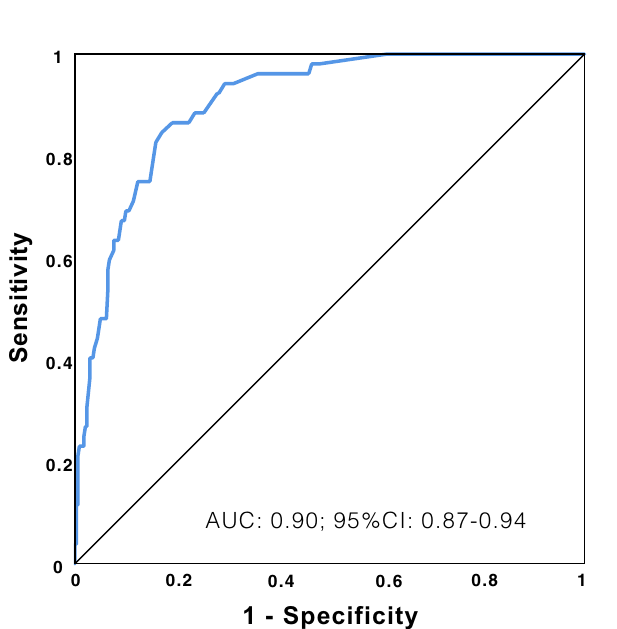
Figure 4. ROC curve of the predictive model of